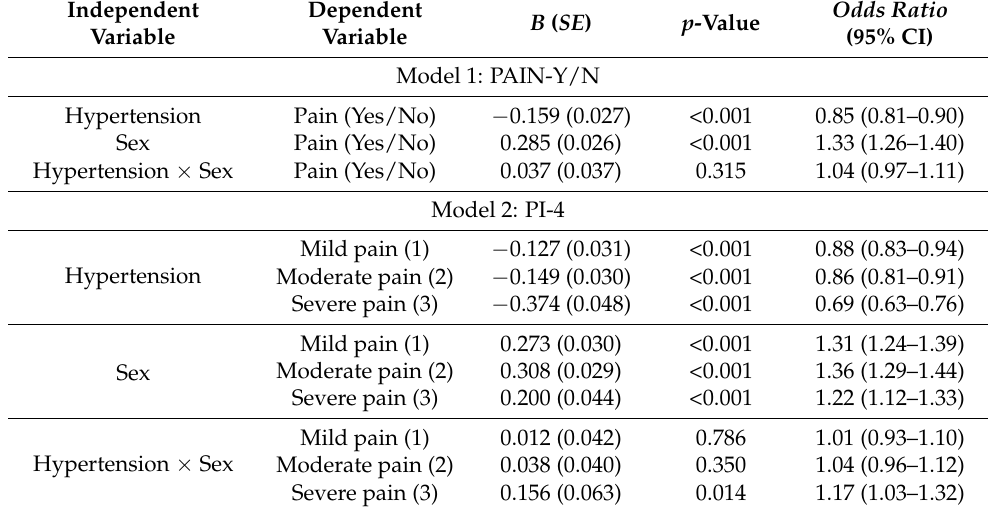
Table 5. Binary and multinomial logistic regression models for dichotomous (PAIN-Y/N) and four- level (PI-4) variables. Each model has been adjusted to include Activities of Daily Living (ADL) scores, Depression Rating Scale (DRS) scores, Index of Social Engagement (ISE) scores, number of medications taken, days taking analgesics, and numbers of emergency room visits and physician visits.